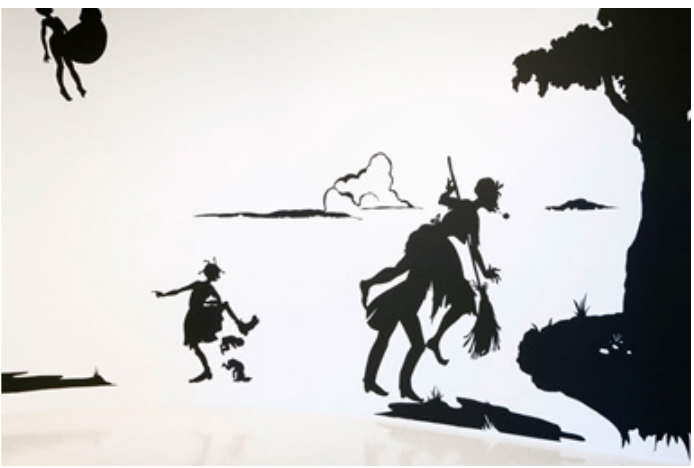
Figure 2. Kara Walker, Gone, An Historical Romance of a Civil War as It Occurred Between the Dusky Thighs of One Young Negress and Her Heart (1994) [DETAIL]. Cut paper on wall; 13 x 50 ft. (4 x 15.2 m). © Sikkema & Jenkins